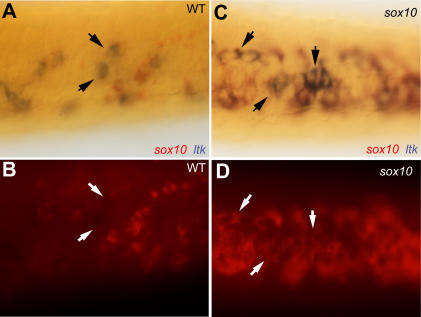
Co-expression of sox10 in ltk-expressing cells in sox10 mutants.Dorsal views of posterior trunk of 30 hpf sox10m618 (C,D) and WT sibling (A,B) embryos double-labelled for sox10 (red) and ltk (purple, arrows). Autofluorescence from red sox10 signal shown in panels B and D.